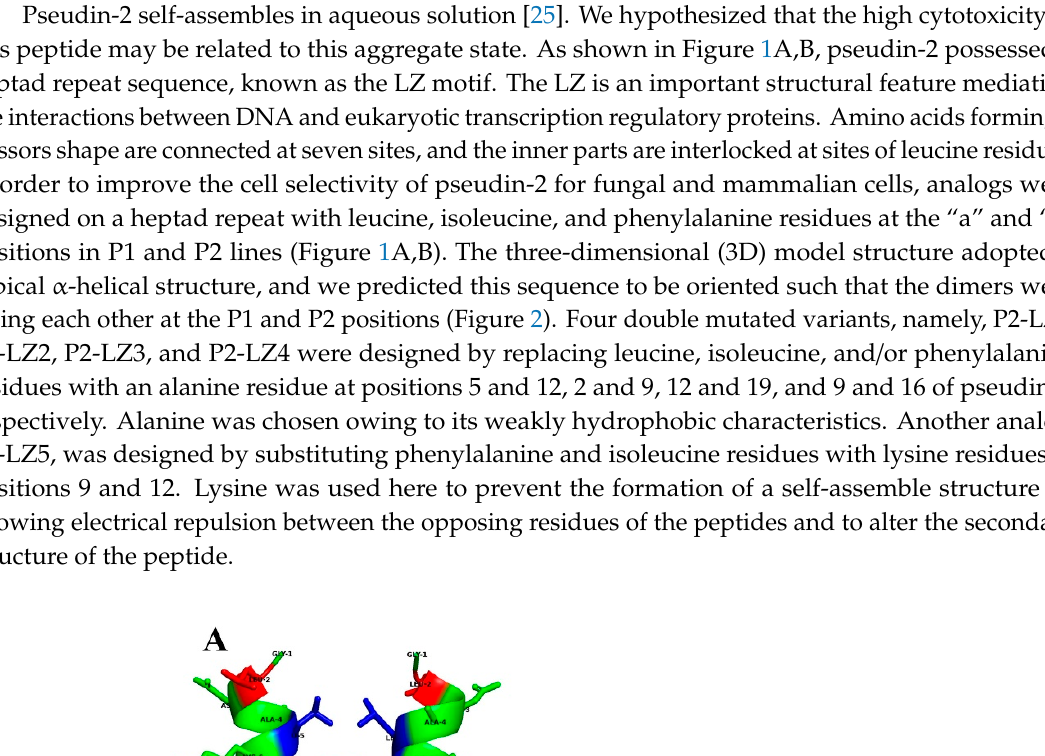
Figure 1. Amino acid substitutions in the leucine-zipper motif of pseudin-2. ( A ) Amino acid sequences of the designated peptides. Amino acids at position “a” are indicated in red and blue colors. ( B ) Helical wheel projection of psuedin-2 in the leucine-zipper orientation.